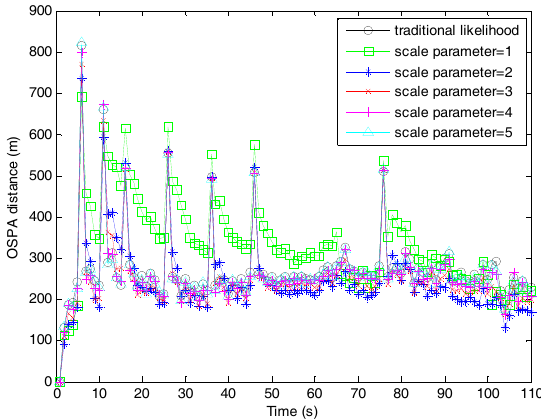
Figure 5. Optimal sub-pattern assignment (OSPA) distances of the SMC adaptive target birth intensity CBMeMBer filter and the fast SMC adaptive target birth intensity CBMeMBer filter.